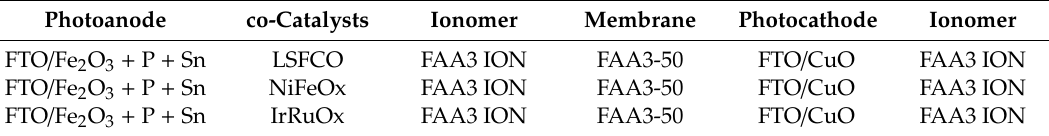
Table 1. Schematization of the co-catalyst-based PEC